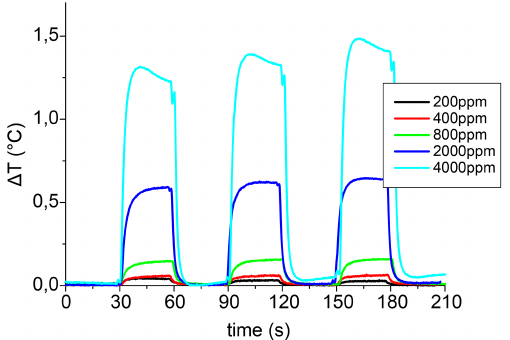
Figure 4. Modelling of the thermal response for a pulse of a given concentration of target gas for a plastic substrate ( λ plastic = 0.15Wm − 1 K − 1 , C plastic = 1800JK − 1 kg − 1 , pink curve) and an inox substrate ( λ inox = 16Wm − 1 K − 1 , C inox = 502JK − 1 kg − 1 , blue curve).